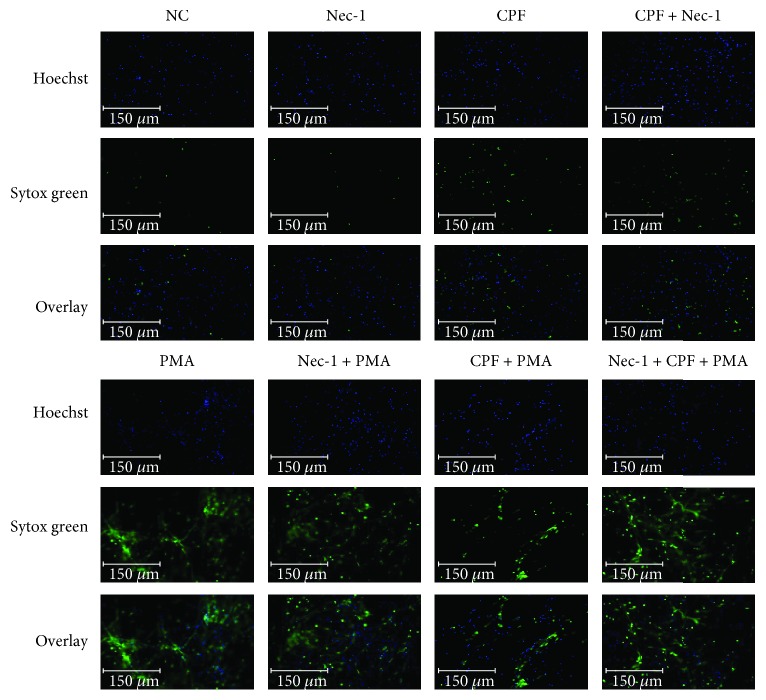
Detection of NETs by fluorescence microscopy. Detection of NETs using Sytox green and Hoechst 33258 dyes. The pictures were taken by a fluorescence microscope. Hoechst 33258 can stain live cells, dead cells, and NETs (blue color). Sytox green can stain dead cells and NETs (green color).